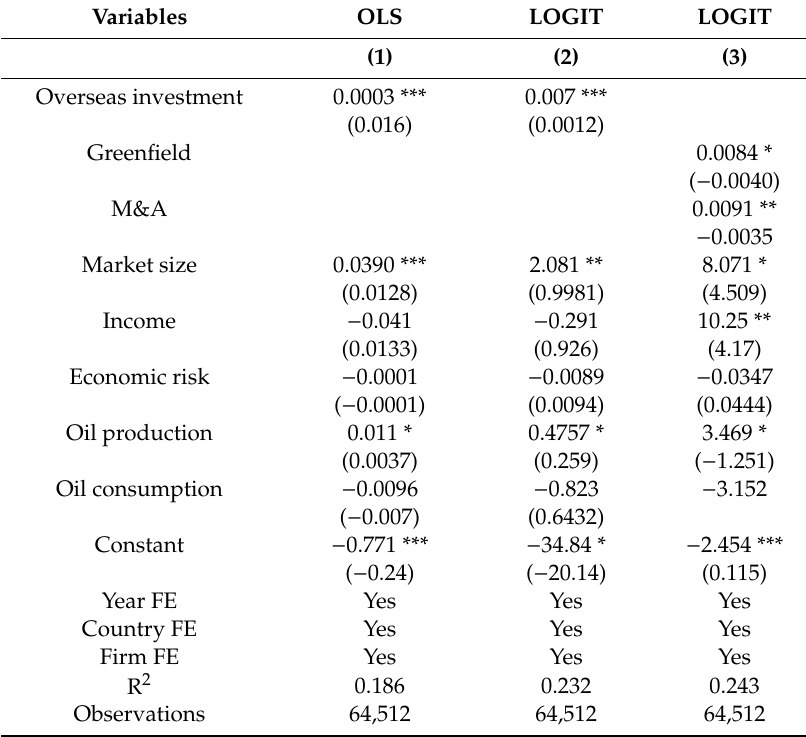
Table 2. Estimation results for the probability of oil import (Equation